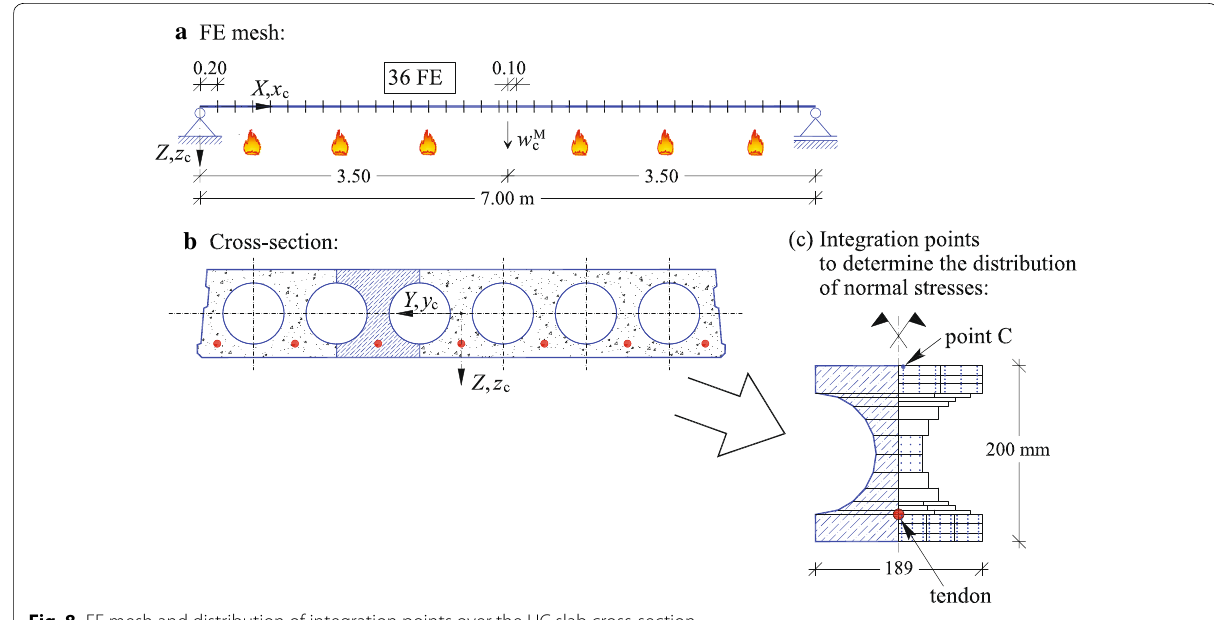
Fig. 8 FE mesh and distribution of integration points over the HC slab cross-section.